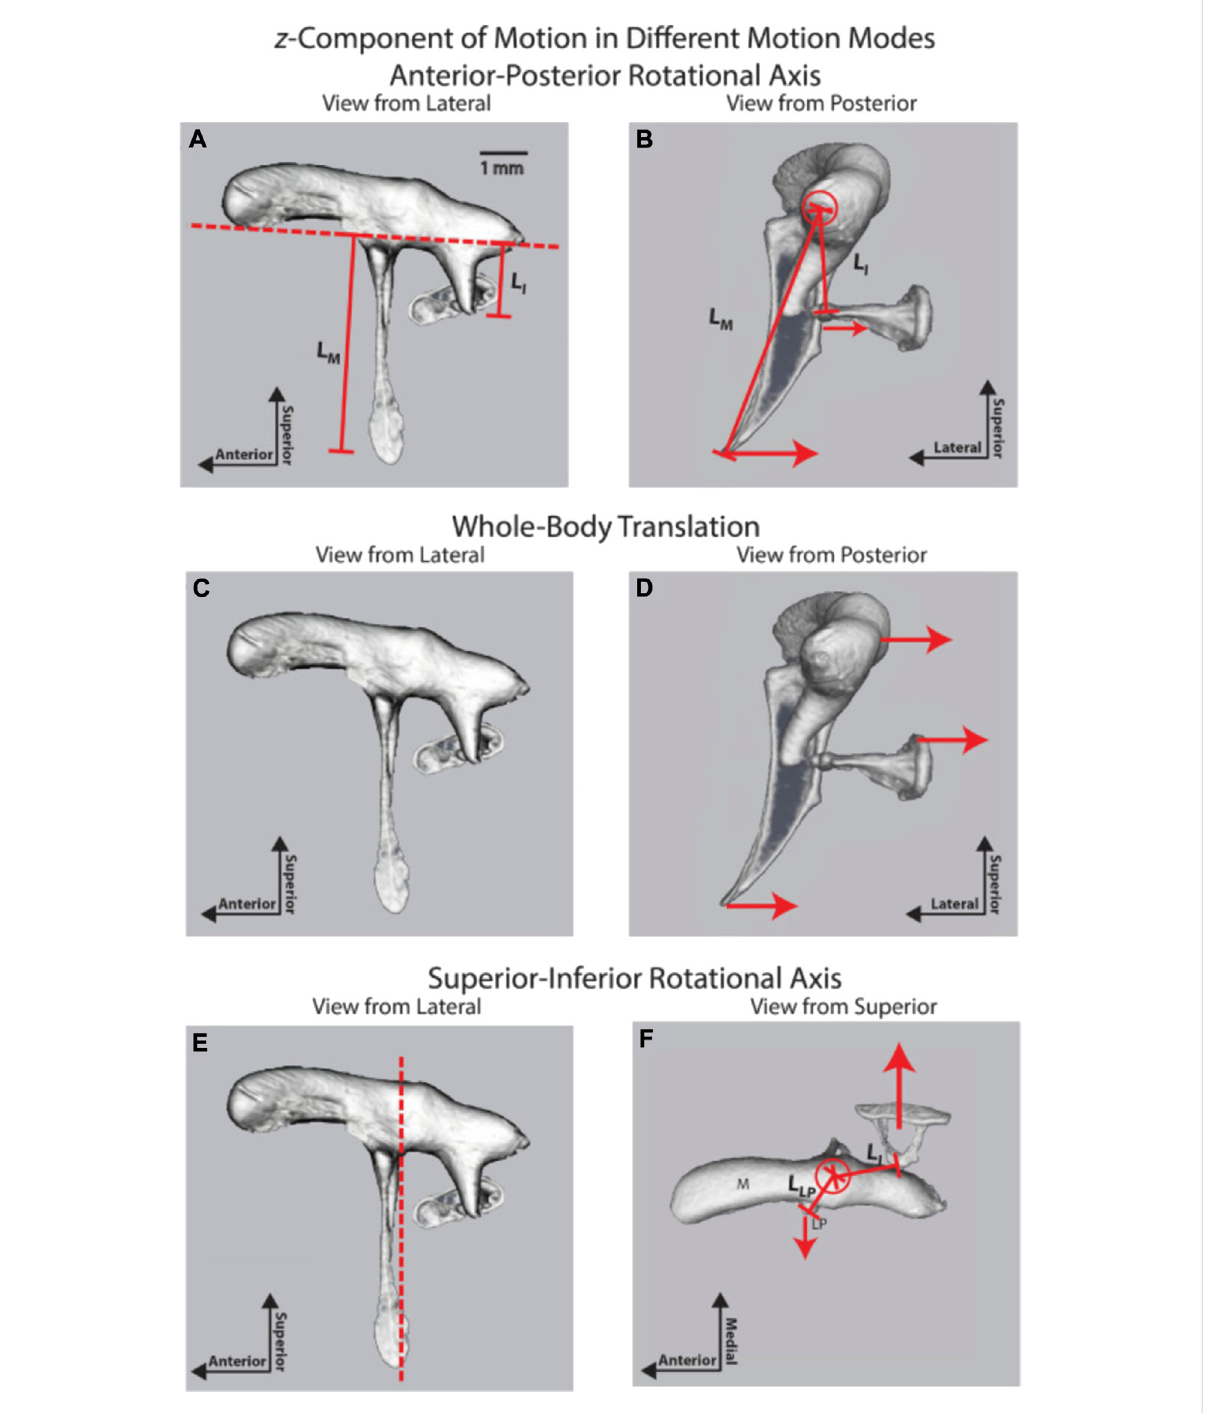
FIGURE 8 Three ossicular motion modes are described by Rosowski et al. (2020); reprinted with permission. (A) lateral and (B) posterior view of the anterior-posteriorrotationalaxis (C) lateraland (D) posteriorviewofthewhole-bodytranslation,and (E) lateraland (F) posteriorviewofthesuperior- inferior rotational